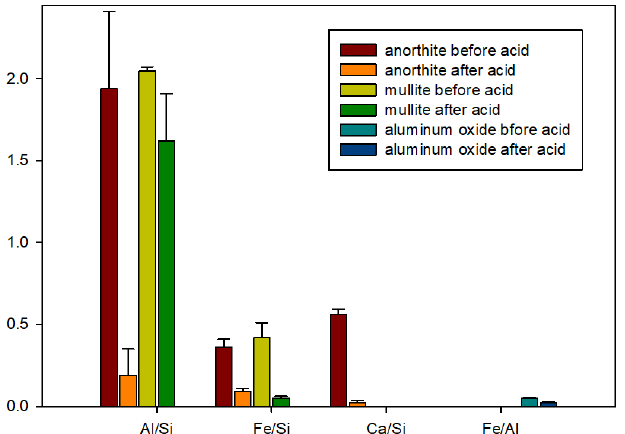
Figure 11. Elemental ratios of surface composition for the tested materials before and after the acid exposure (µEDX measurements).